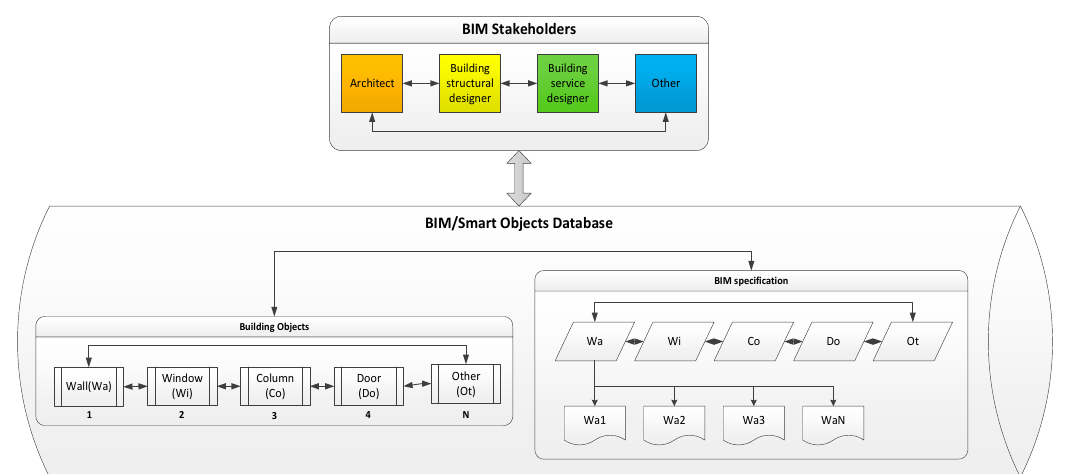
Figure 2. The architecture of the interaction between the user level (BIM stakeholders) driven database of BIM/Smart objects in information management of building construction projects (devised by the authors based on the literature).